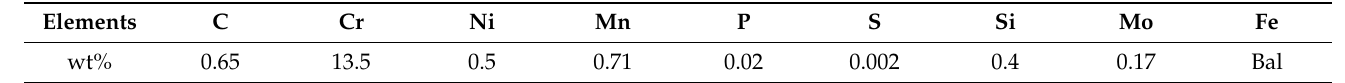
Table 1. Chemical composition of 6Cr13 martensitic stainless